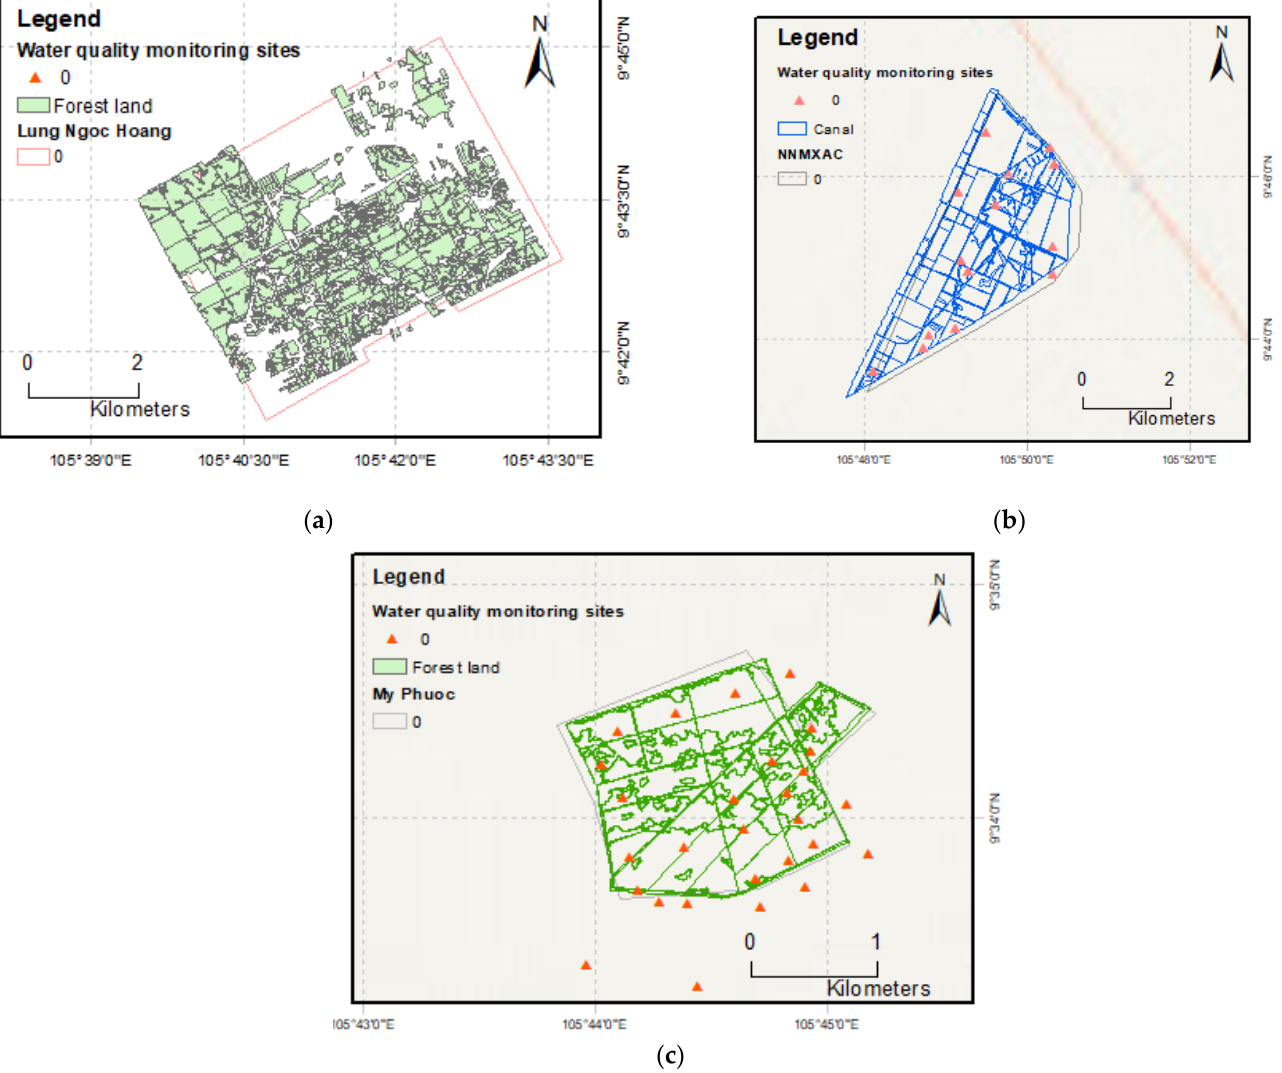
Figure 2. Water sampling locations at ( a ) Lung Ngoc Hoang Natural Reserve; ( b ) Mua Xuan Agriculture Center; ( c ) My Phuoc melaleuca forest.